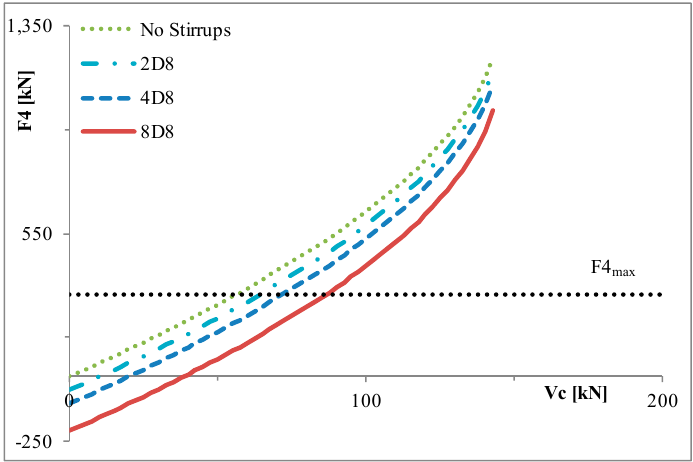
Figure 7. Parametric analysis: tensile force, F 4 , in beam bars and its threshold with variability of stirrups.